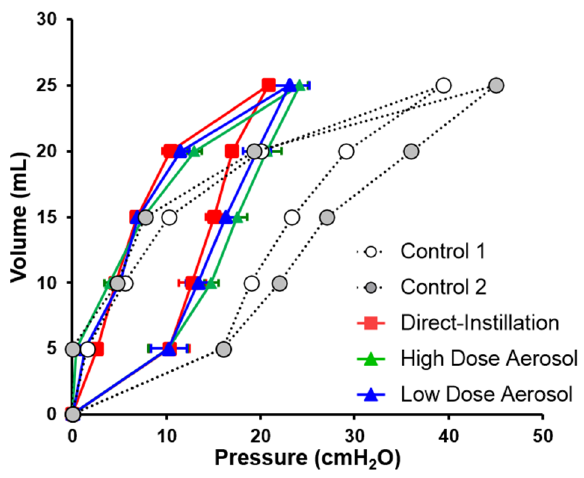
Figure 6. Post-mortem inflation and deflation curves. Pressure values shown are means ± SD for inspiratory and expiratory volumes (0–25 mL). Static compliance was calculated based on mean values at for separate conditions based on a linear fit model. Static compliance values were 1.2 ± 0.02, 1.1 ± 0.04, and 1.1 ± 0.09 mL/cmH 2 O, for Direct-Instillation, High Dose Aerosol, and Low Dose Aerosol, respectively. Compliance and closing pressures at 20 mL (FRC) were not different between treatment groups. Controls are shown for descriptive purposes but were underpowered and not included in the statistical